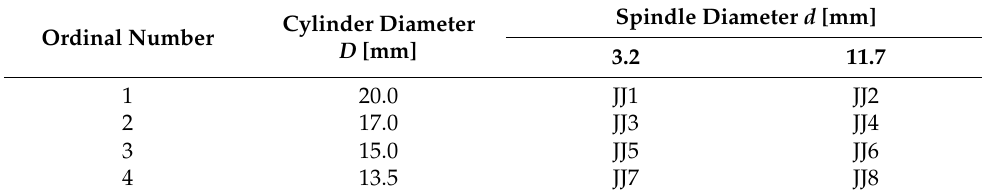
Table 2. Markings of sets “spindle/cylinder”.